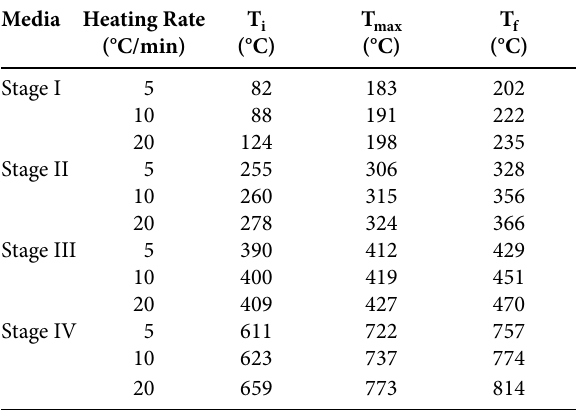
Table 2. Specific temperatures of the CTT crystals decomposition process.